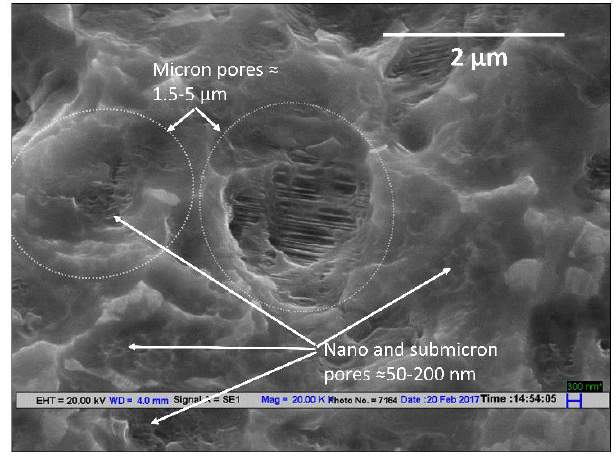
Figure 5. SEM images of sandblasted dental implant acid-etched with HF for 30 s (RT) and second etching with HCl + H 2 SO 4 at HT for a duration of 5 min at 20,000× magnification.